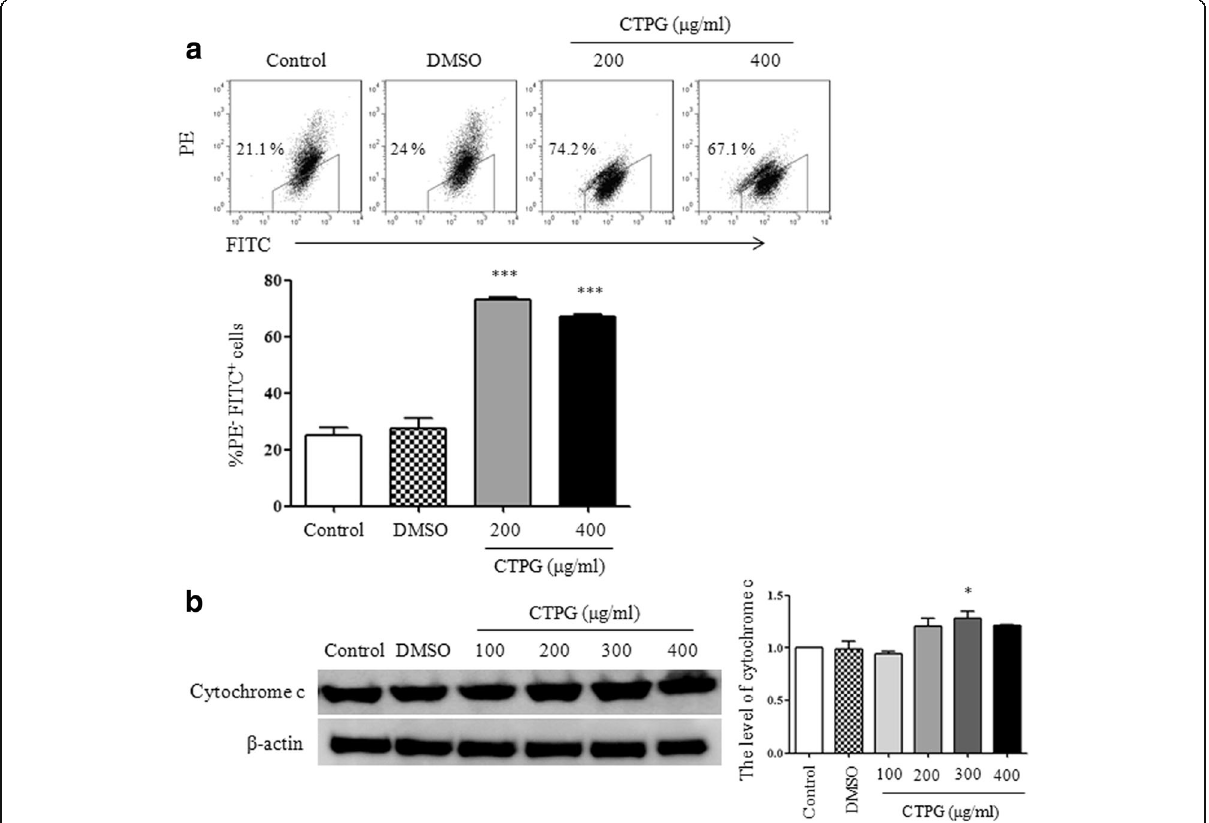
Fig. 4 The reduction of Δψ m and release of cytochrome c. H22 cells were treated with different concentrations of CTPG for 24 h. ( a ) Cells were stained with JC-1 dye and analyzed by flow cytometry. The individual dot plots show the changes of JC-1 fluorescence. The summary data are shown in the lower panel. ( b ) Total protein was isolated to detect the release of cytochrome c by Western blot. * p < 0.05; *** p < 0.001